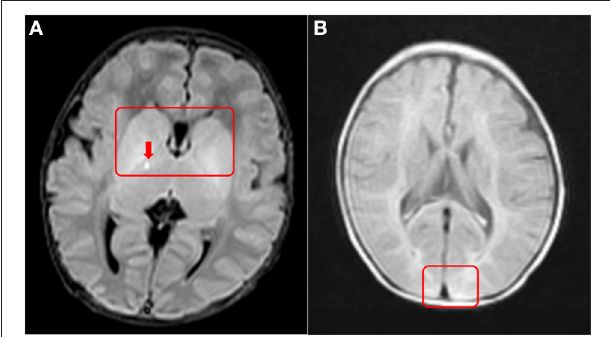
FIGURE 1 | Brain MRI at 10 days and 3 months of age. (A) T2W: Red boxes indicate a high signal of basal ganglia, swelling of bilateral lenticular nucleus; Red arrows indicate an abnormal signal point of posterior branch of right internal capsule. (B) T2W: Red boxes indicate white matter of occipital lobe has high signal, and the boundary of gray and white matter is not clear.